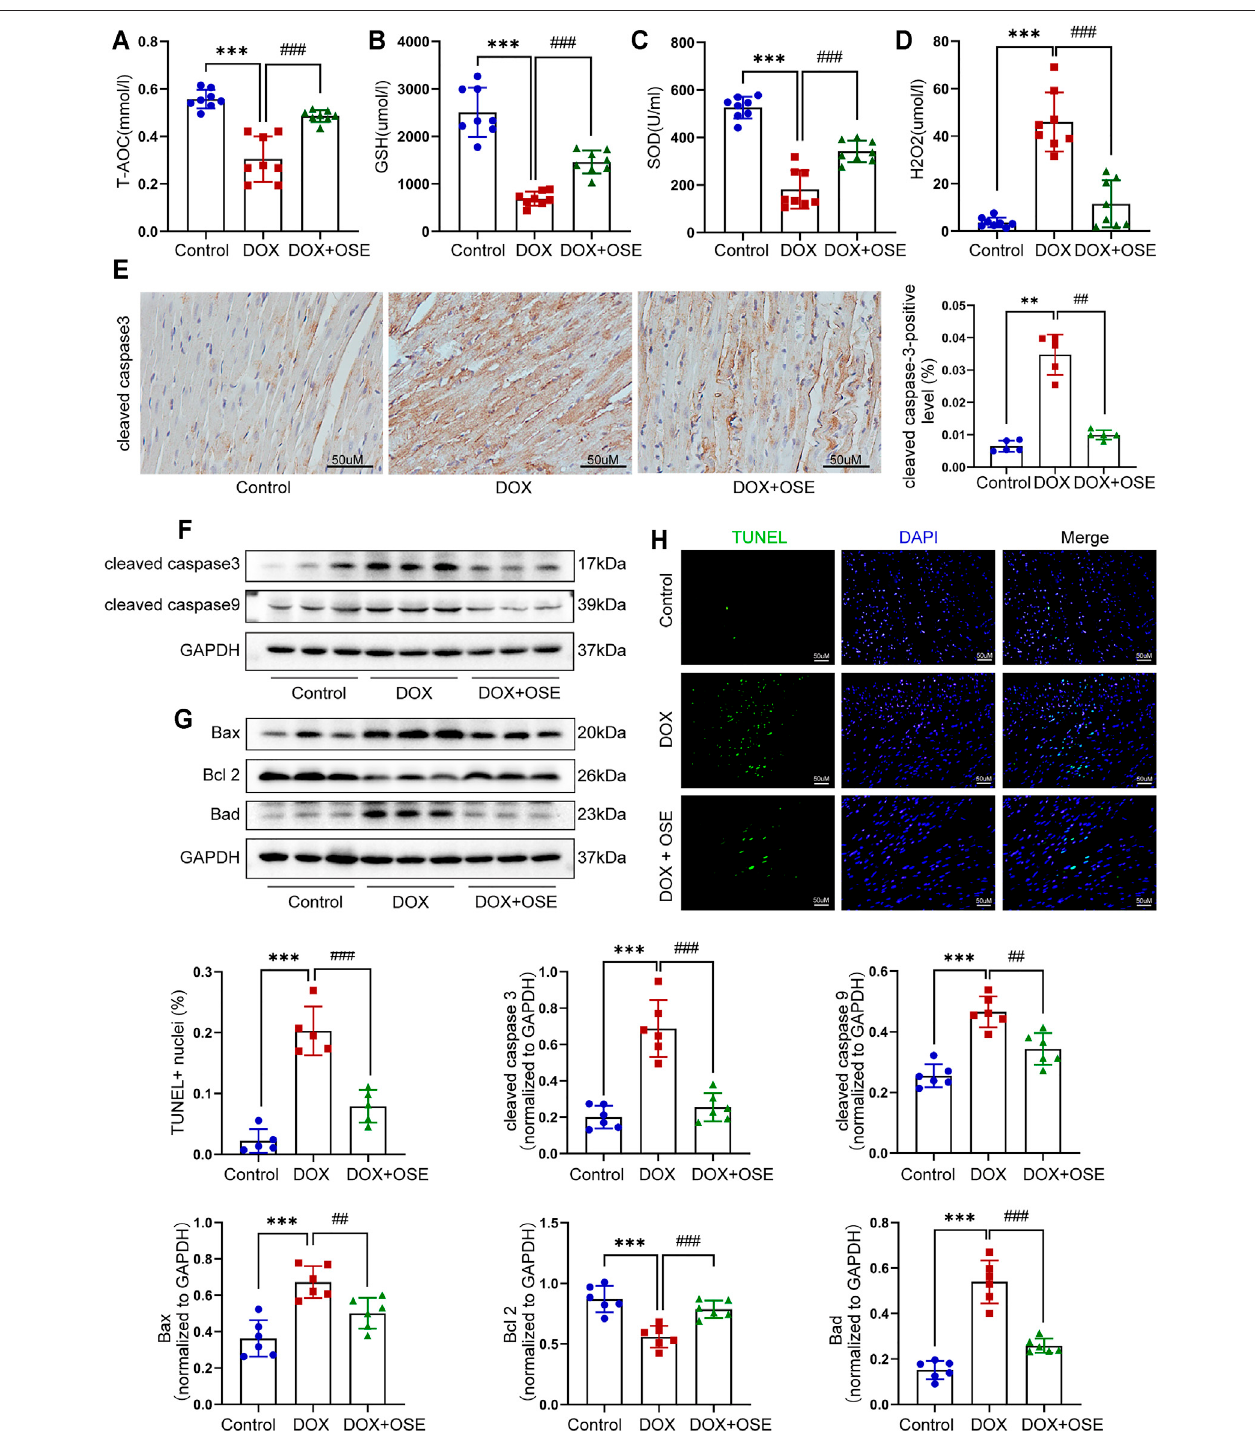
FIGURE 4 | NEU1 inhibitor effectively prevented apoptosis in DOX-treated rat hearts. The concentrations of endogenous antioxidants including total antioxidant capacity (T-AOC) (A) , glutathione (GSH) (B) , superoxide dismutase (SOD) (C) , and endogenous oxidative factor hydrogen peroxide (H 2 O 2 ) (D) in blood serum measured bycommercialassays. (E) Representativeimmunohistochemicalimagesofcleaved caspase-3abundancein hearttissuesofthethreegroups( n (cid:1) 5 per group, scale bar (cid:1) 50 μ m). The expression levels of cleaved caspase-3 and cleaved caspase-9 (F) and Bax, Bcl-2, and Bad (G) in heart tissues of the threegroupsbywesternblot( n (cid:1) 6pergroup). (H) Terminaldeoxynucleotidyltransferase-mediated dUTPnick end labeling(TUNEL) stainingofhearttissuesin three groups; positive nuclei were stained in green while nuclei were stained in blue ( n (cid:1) 5 per group, scale bar (cid:1) 50 μ m). (** p < 0.01 vs. control group, *** p < 0.001 vs. control group. ## p < 0.01 vs. DOX group, ### p < 0.001 vs. DOX group).